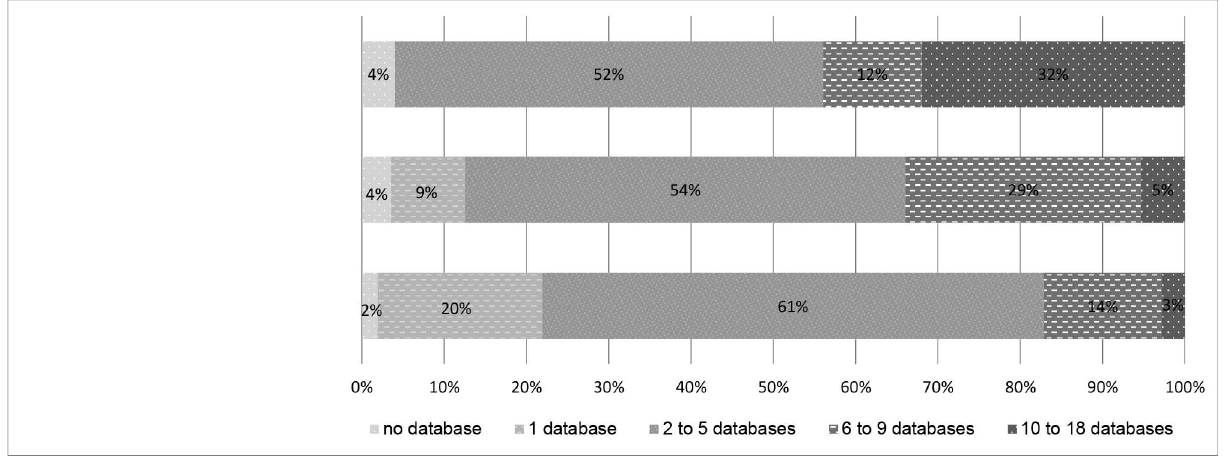
The percentage of frequencies of databases reported in each category of systematic reviews (Without Librarian, Librarian as Consultant, Librarian as Coauthor/Team